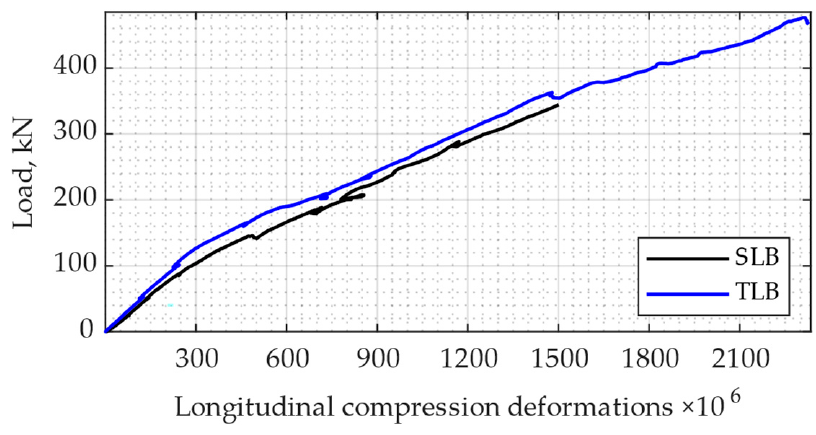
Figure 5. Typical load–longitudinal deformation diagram.